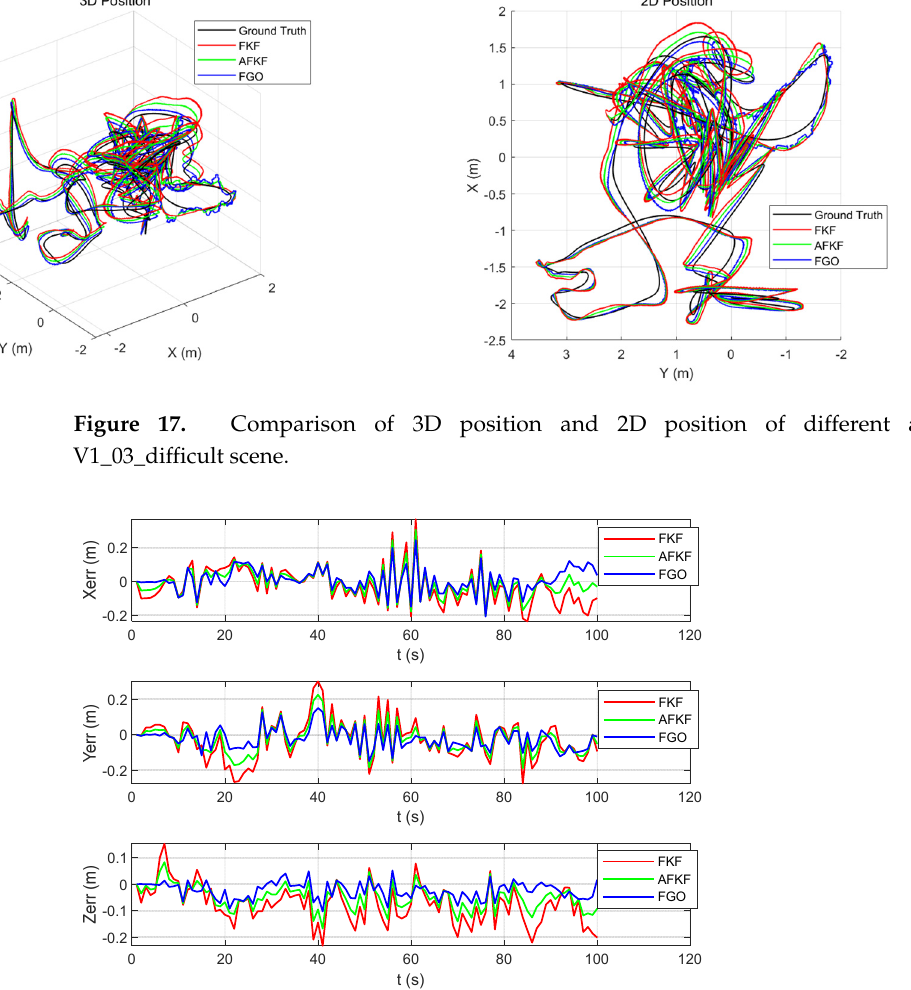
Figure 18. Comparison of position errors of different algorithms in V1_03_difficult scene.